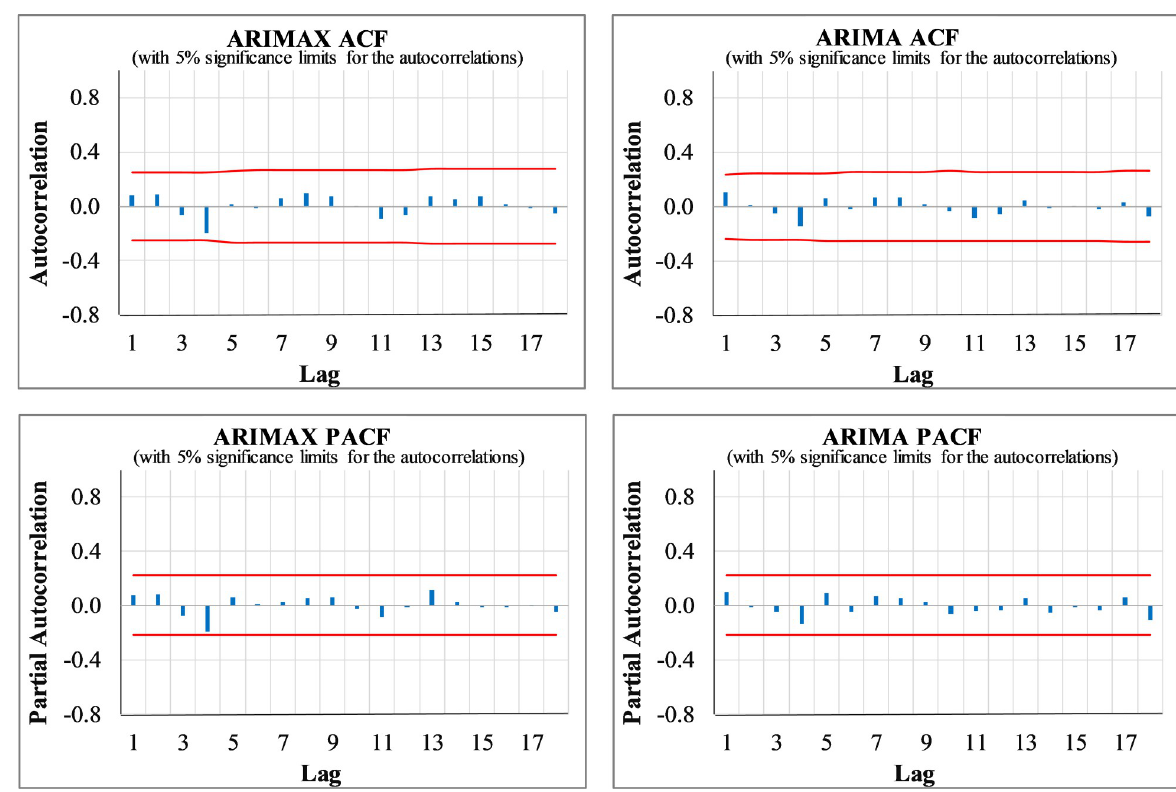
Fig 5. The residuals ACF/PACF plots of the ARIMAX and ARIMA weekly COVID deaths prediction models.